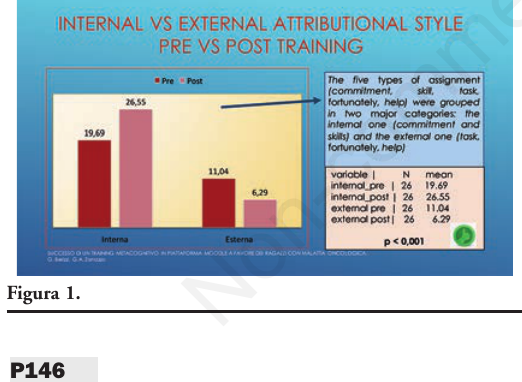
P146 ARTETERAPIA E TRAPIANTO DI MIDOLLO OSSEO: UN PERCORSO ATTRAVERSO LE